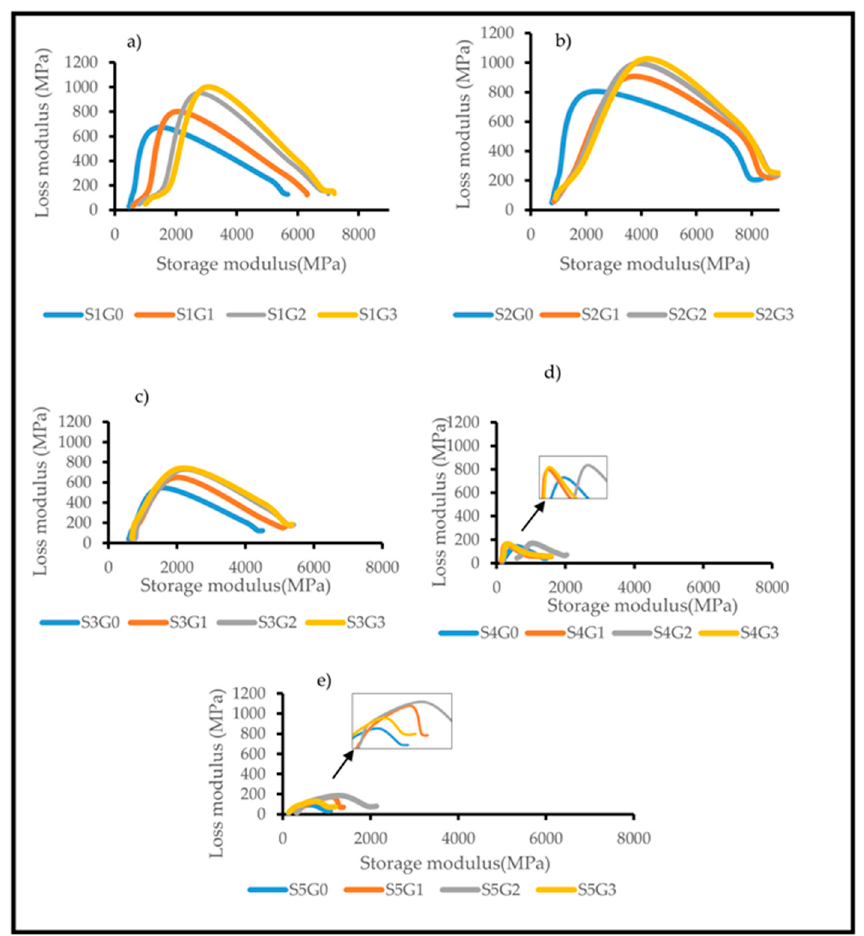
Figure 10. E ff ect of GNP on the Cole–Cole plot of laminated composites. ( a ) S1, ( b ) S2, ( c ) S3, ( d ) S4, ( e )